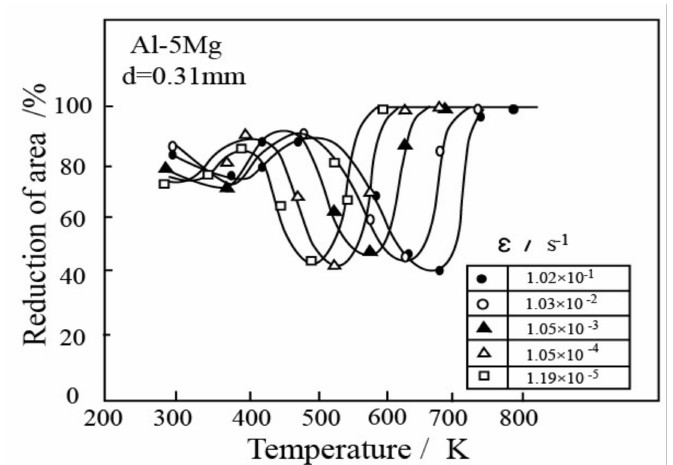
Figure 4. Reduction of area versus test temperature for Al-5 wt%Mg alloy after deformation with various strain rates ranging from